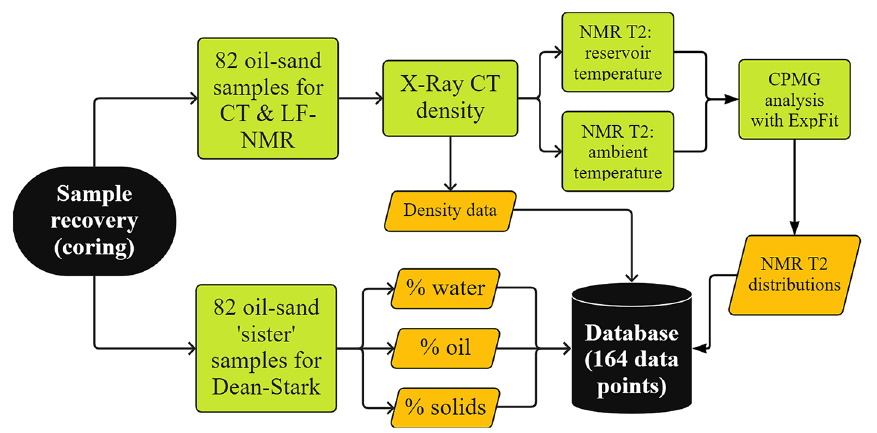
Figure 2. Flowchart representing the experimental program for oil-sands samples, by X-ray CT, LF-NMR T 2 measurements and Dean-Stark